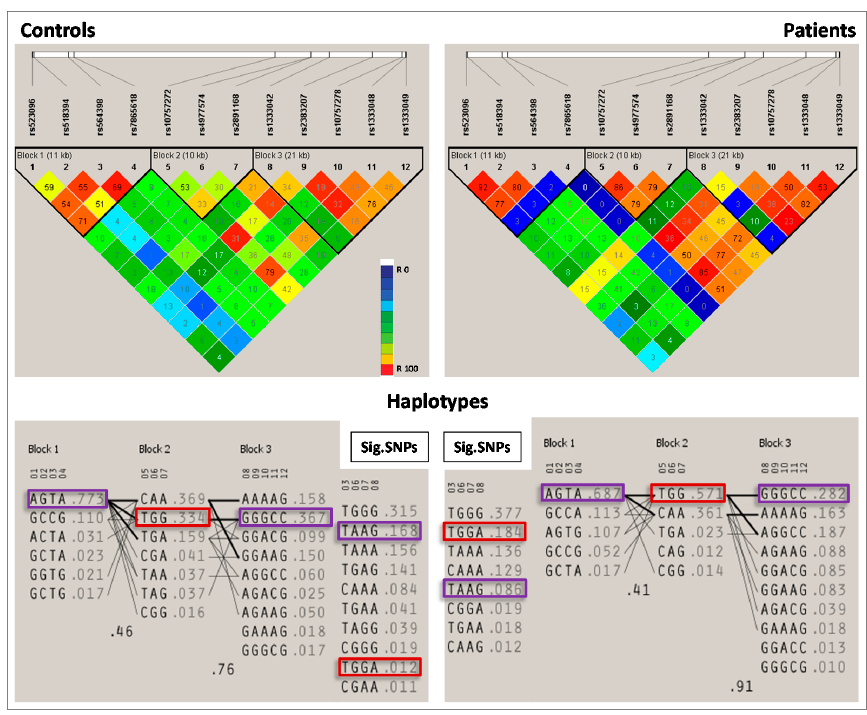
Figure 1. Upper half : Haploview LD (linkage disequilibrium) plot of the 12 SNPs in 9p21 locus. The pairwise correlation between the single nucleotide polymorphisms (SNPs) were measured as r 2 and shown (×100) in each diamond. Lower half : Haplotypes of patient group and controls. Protective haplotypes are in purple boxes and risk haplotypes are in red boxes. Sig. SNPs: Block and haplotypes of significant SNPs.